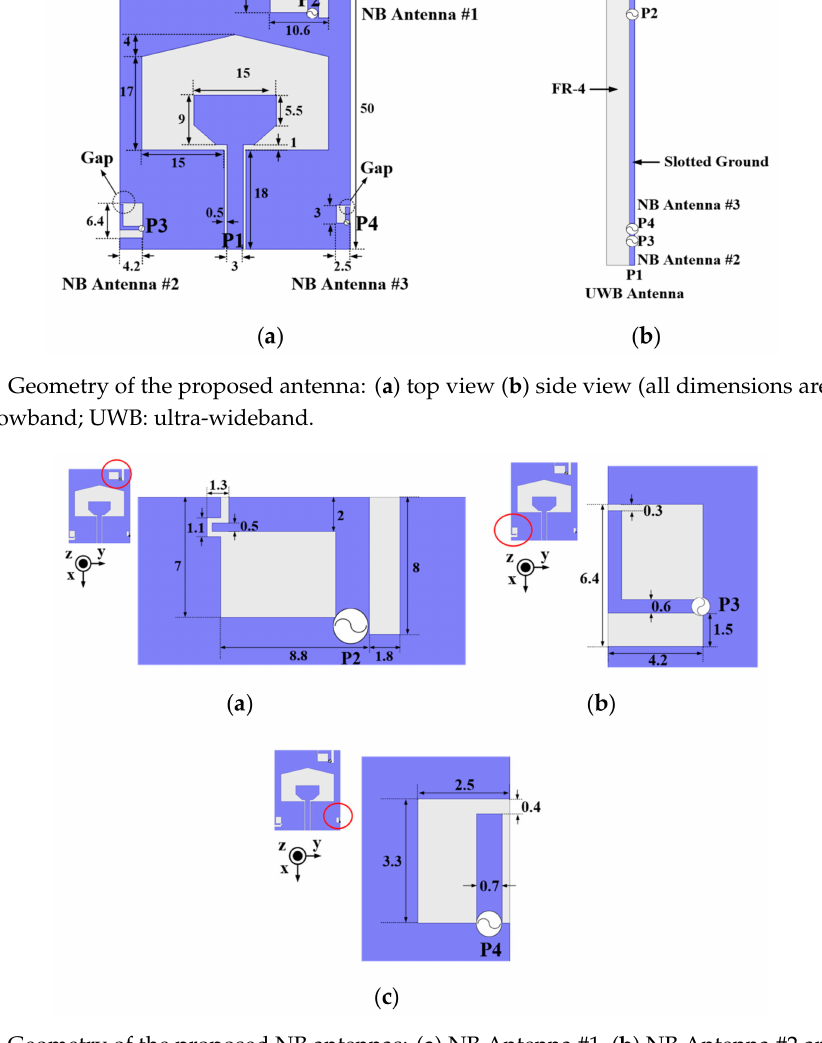
Figure 2. Geometry of the proposed NB antennas: ( a ) NB Antenna #1, ( b ) NB Antenna #2 and ( c ) NB Antenna #3 (all dimensions are in